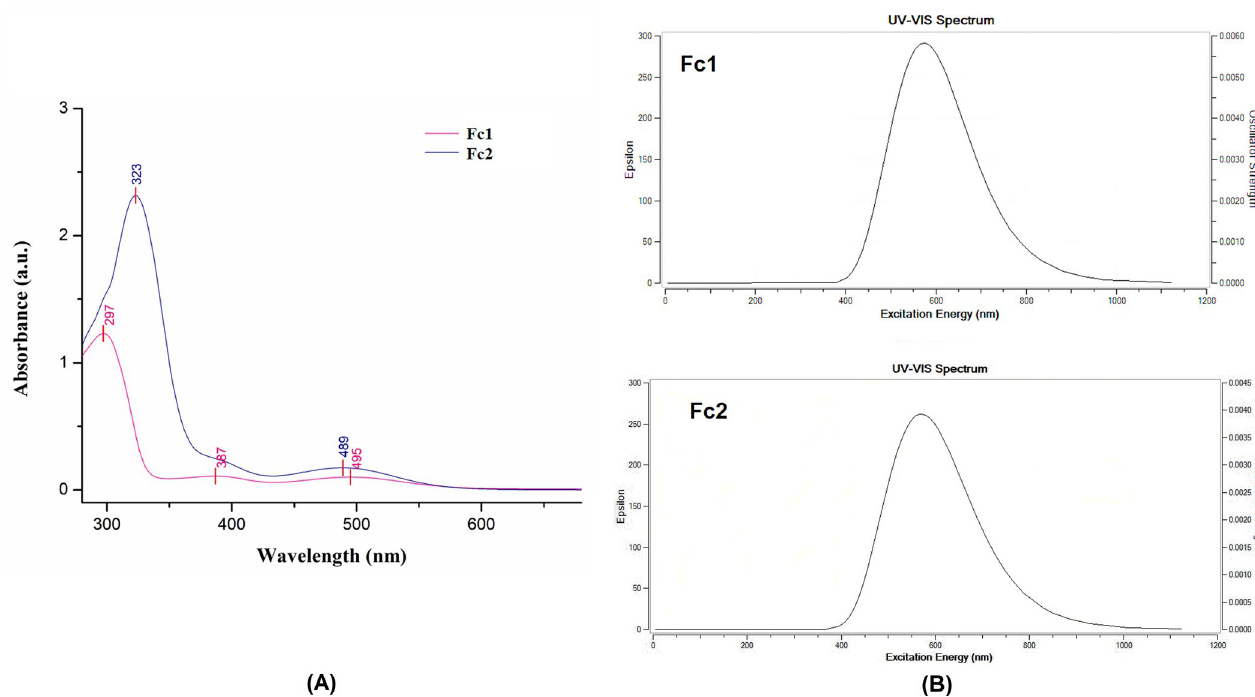
Fig 8. UV-Vis spectra of Fc1 and Fc2. (A) The experimental UV-Vis spectra recorded in acetonitrile. (B) The theoretical UV-Vis spectra using B3LYP/6-311G ++(d,p).